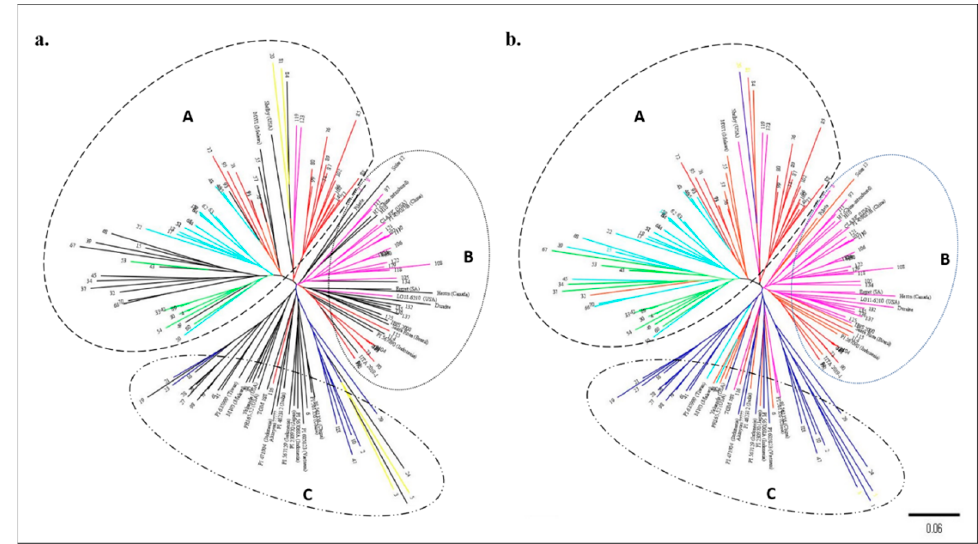
Figure 4. Neighbor-joining phylogenetic tree of the 155 soybean lines based on 186 SNP markers. The color patterns are equivalent to the STRUCTURE analysis (based on >60% identity) at K = 6 ( a ) and DAPC analysis K = 5 ( b ). Black color represents admixture inbred line.